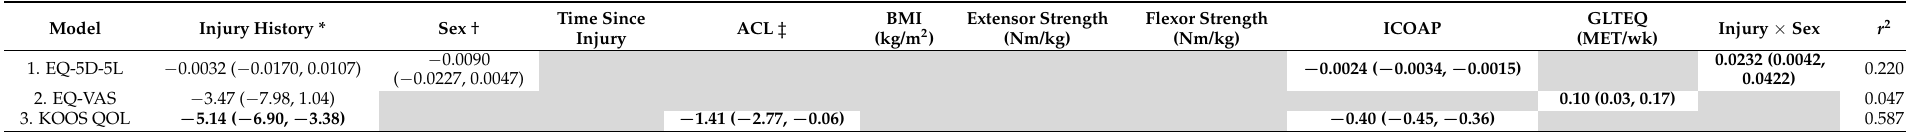
Table 3. Multivariable linear regression models for injury history and HRQoL outcomes considering determinants of HRQoL and osteoarthritis